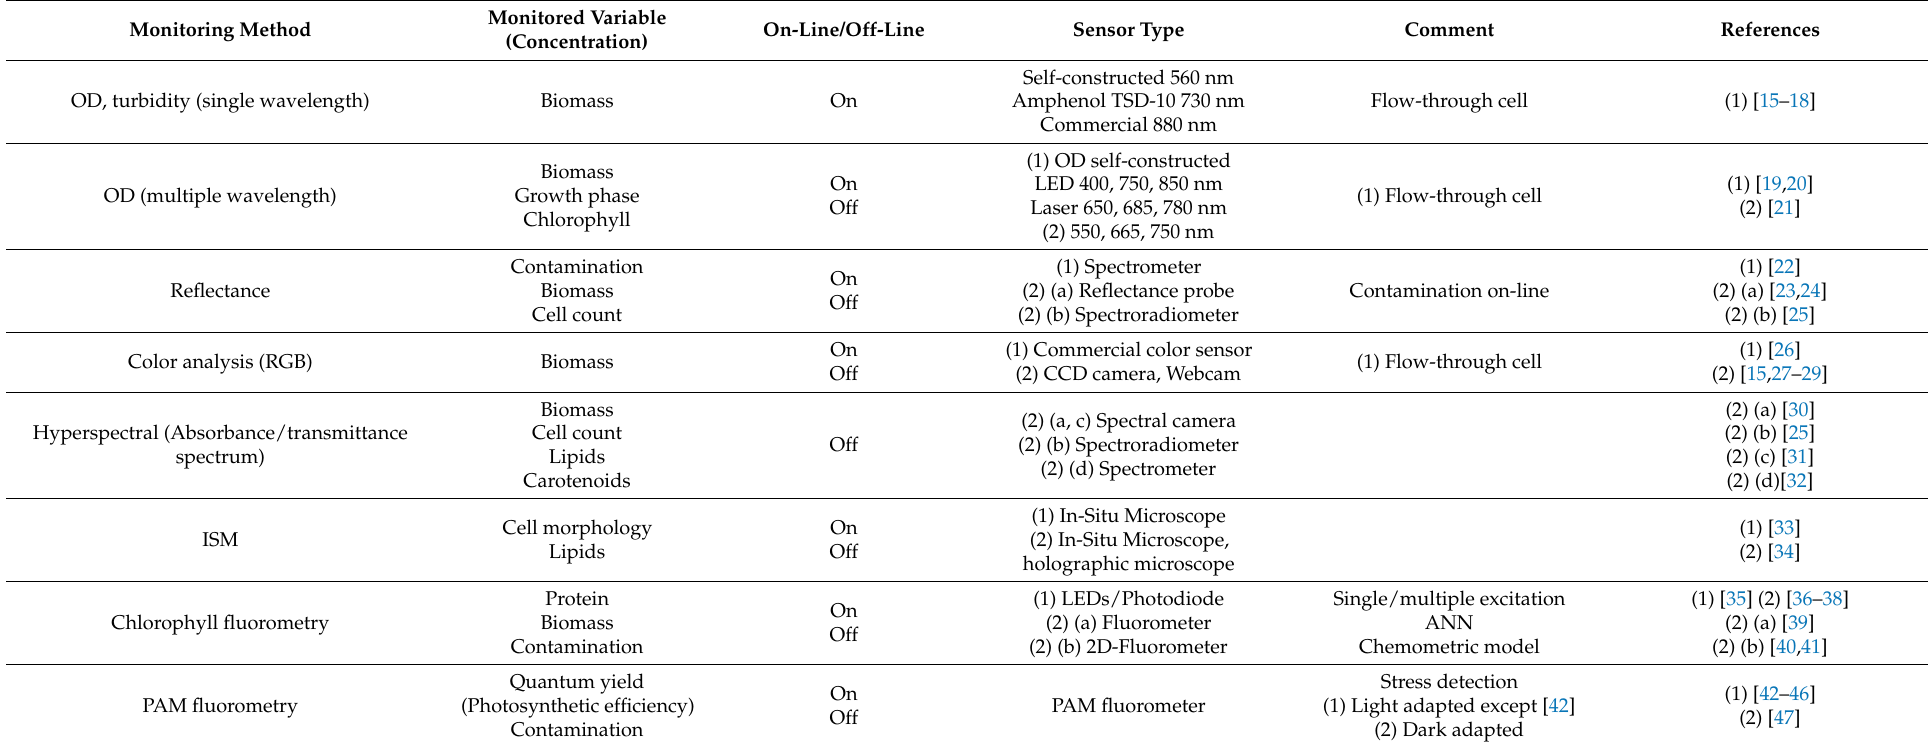
Table 1. Monitoring method of biological variables in microalgal cultivations implemented on-line or with on-line potential. (PAM: pulse amplitude modulation, a fluorescence technique; ANN: artificial neural networks; ISM: In-Situ